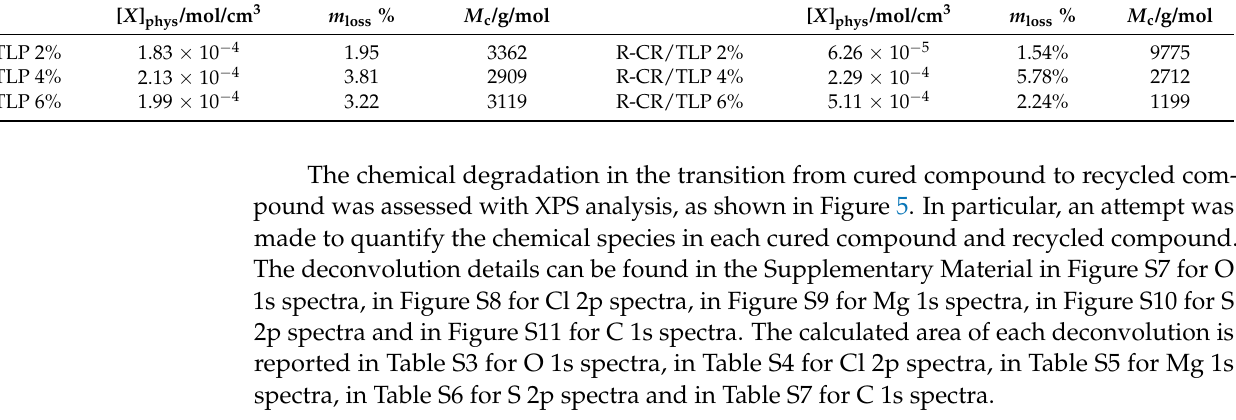
Cured Compounds Recycled